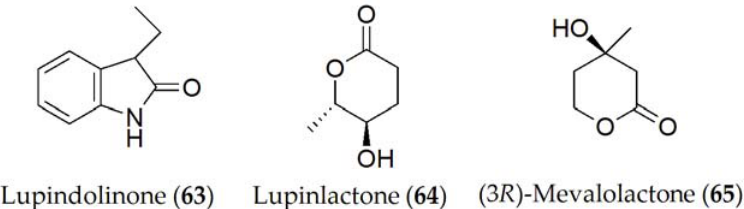
Figure 10. Phytotoxins isolated from Colletotrichum lupini .